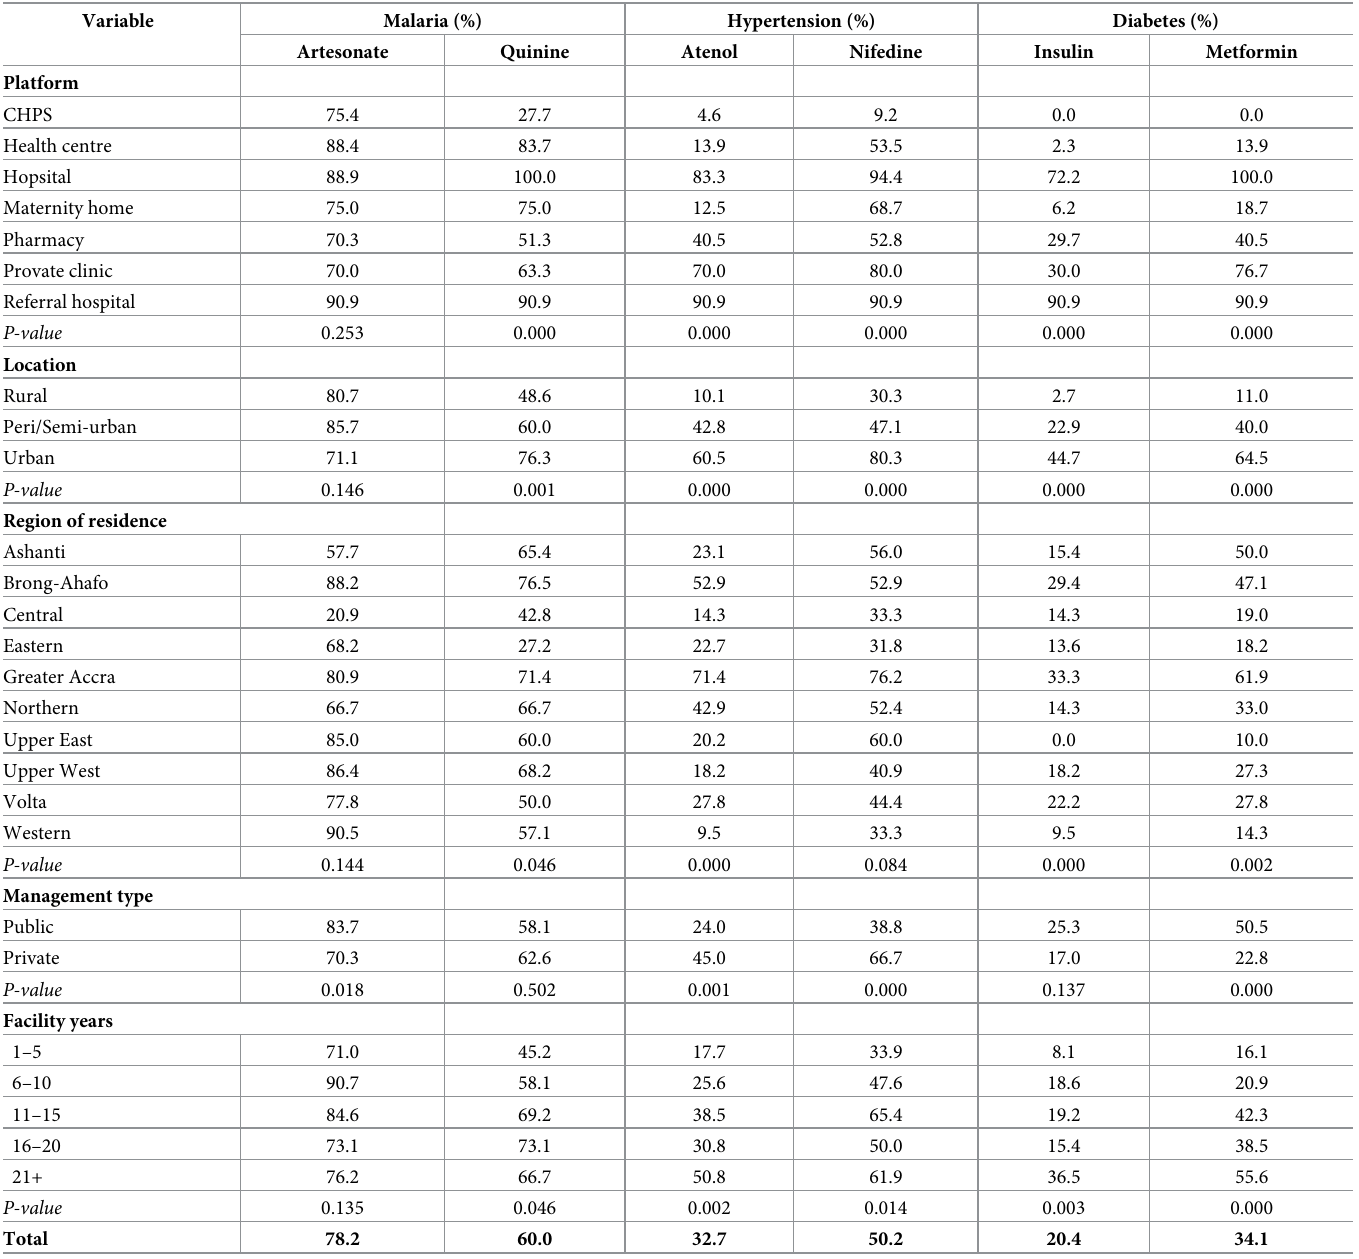
Table 5. Treatment of malaria, hypertension and diabetes by facility characteristics,